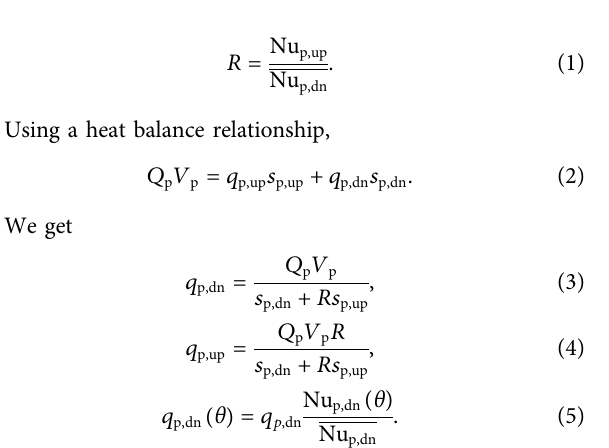
FIGURE 4 | Schematic diagram of three-layer molten pool with parameters.